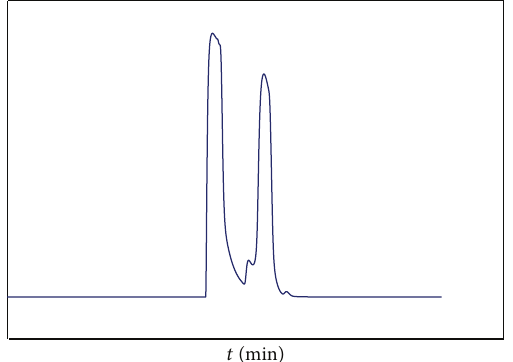
Figure 4: Chromatogram of methanol and methyl